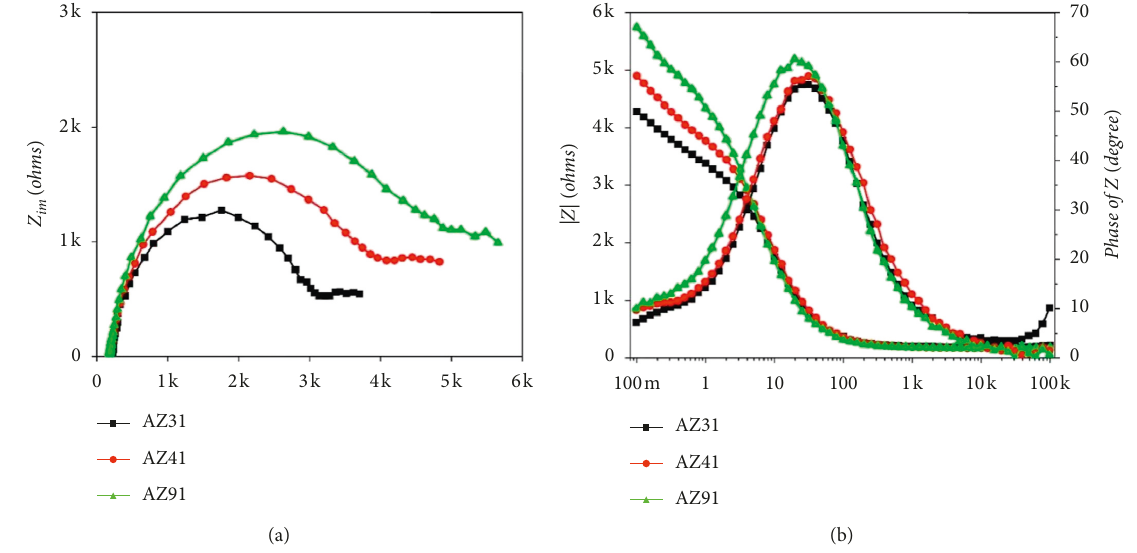
Figure 5: The corrosion impedance capability of each alloy in EIS experiments. (a) The arc radius dimensions symbolizing the corrosion impedance properties of the tested alloys. (b) Directive variation curve of impedance with frequency